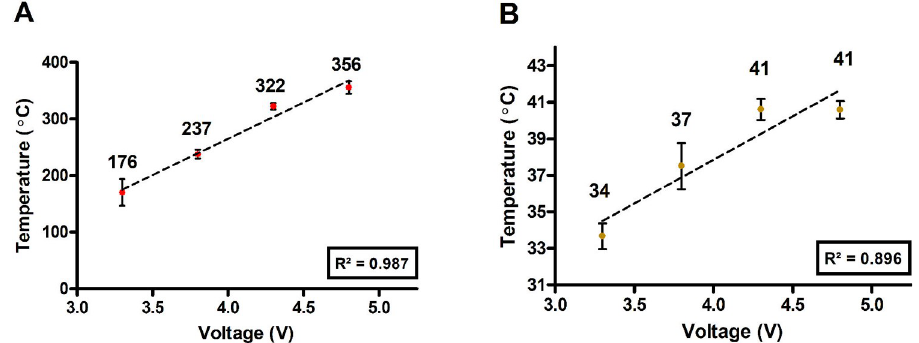
Fig 2. Average peak temperatures vs. voltage. Linear graph of (A) coil and (B) oil average peak temperatures versus each voltage setting of the e-cigarette device.